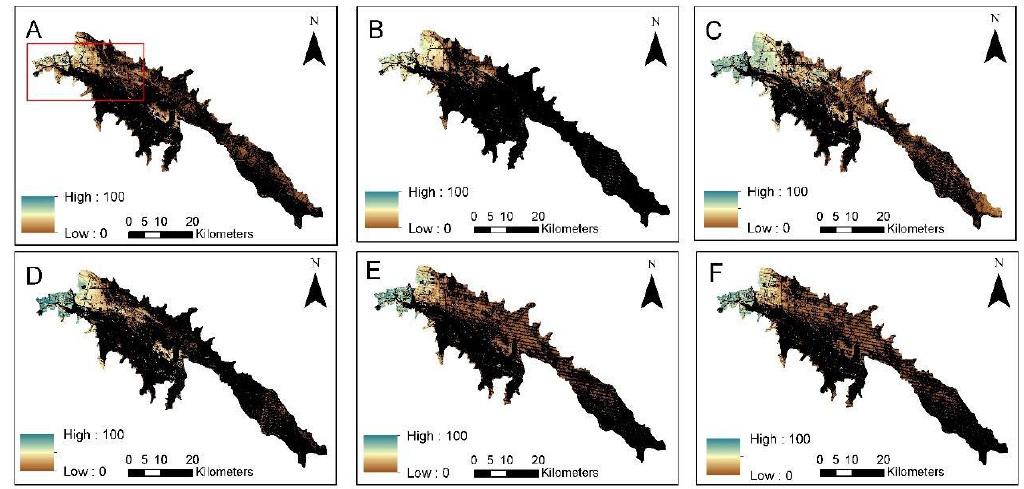
Figure 8. 5-year average ESI values across Upper Coachella Valley and Hills ecoregion. Red box in panel A outlines the wind energy areas. Blue values indicate persistent yearly high ( > 0.2) values over Figure 8. Five-year average ESI index values across the Upper Coachella Valley and Hills Ecoregion each period. Periods are ( A ) 1989–1993, ( B ) 1994–1998, ( C ) 1999–2003, ( D ) 2004–2008, ( E ) 2009–2013, for six periods: ( a ) 1989 – 1993, ( b ) 1994 – 1998, ( c ) 1999 – 2003, ( d ) 2004 – 2008, ( e ) 2009 – 2013, and ( f ) and ( F ) 2014–2018. 2014 – 2018. The red box in (A) outlines the wind energy areas. Blue values indicate persistent yearly high (>0.2) values over each period.